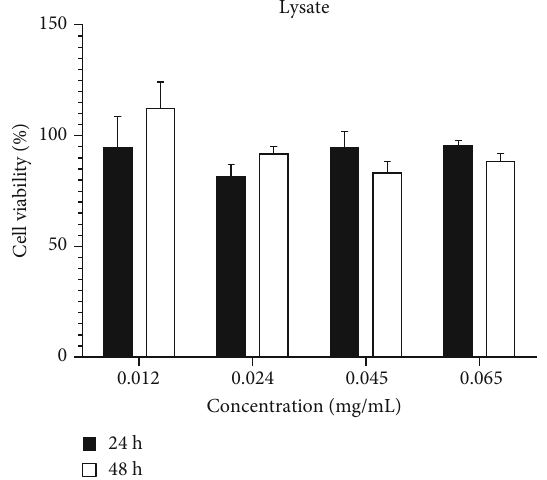
Figure 4: E ff ect of lysate of microorganism of ke fi r on U87 cell viability after 24 and 48 hours ( P value ≤ 0.5).